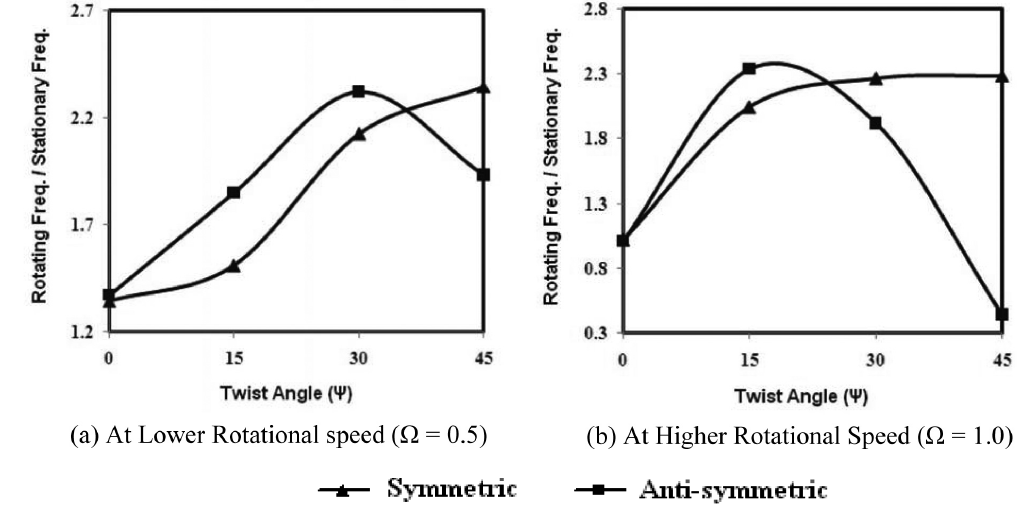
Fig. 6. Comparative representation of ratio of rotating frequency and stationary frequency for symmetric and anti-symmetric four layered graphite-epoxy cross-ply composite pretwisted rotating shallow conical shells, considering h = 0.0004, s/h = 1000, L/s = 0.7, d/L = 0.5, θ o = 45 ◦ , θ v = 20 ◦ .